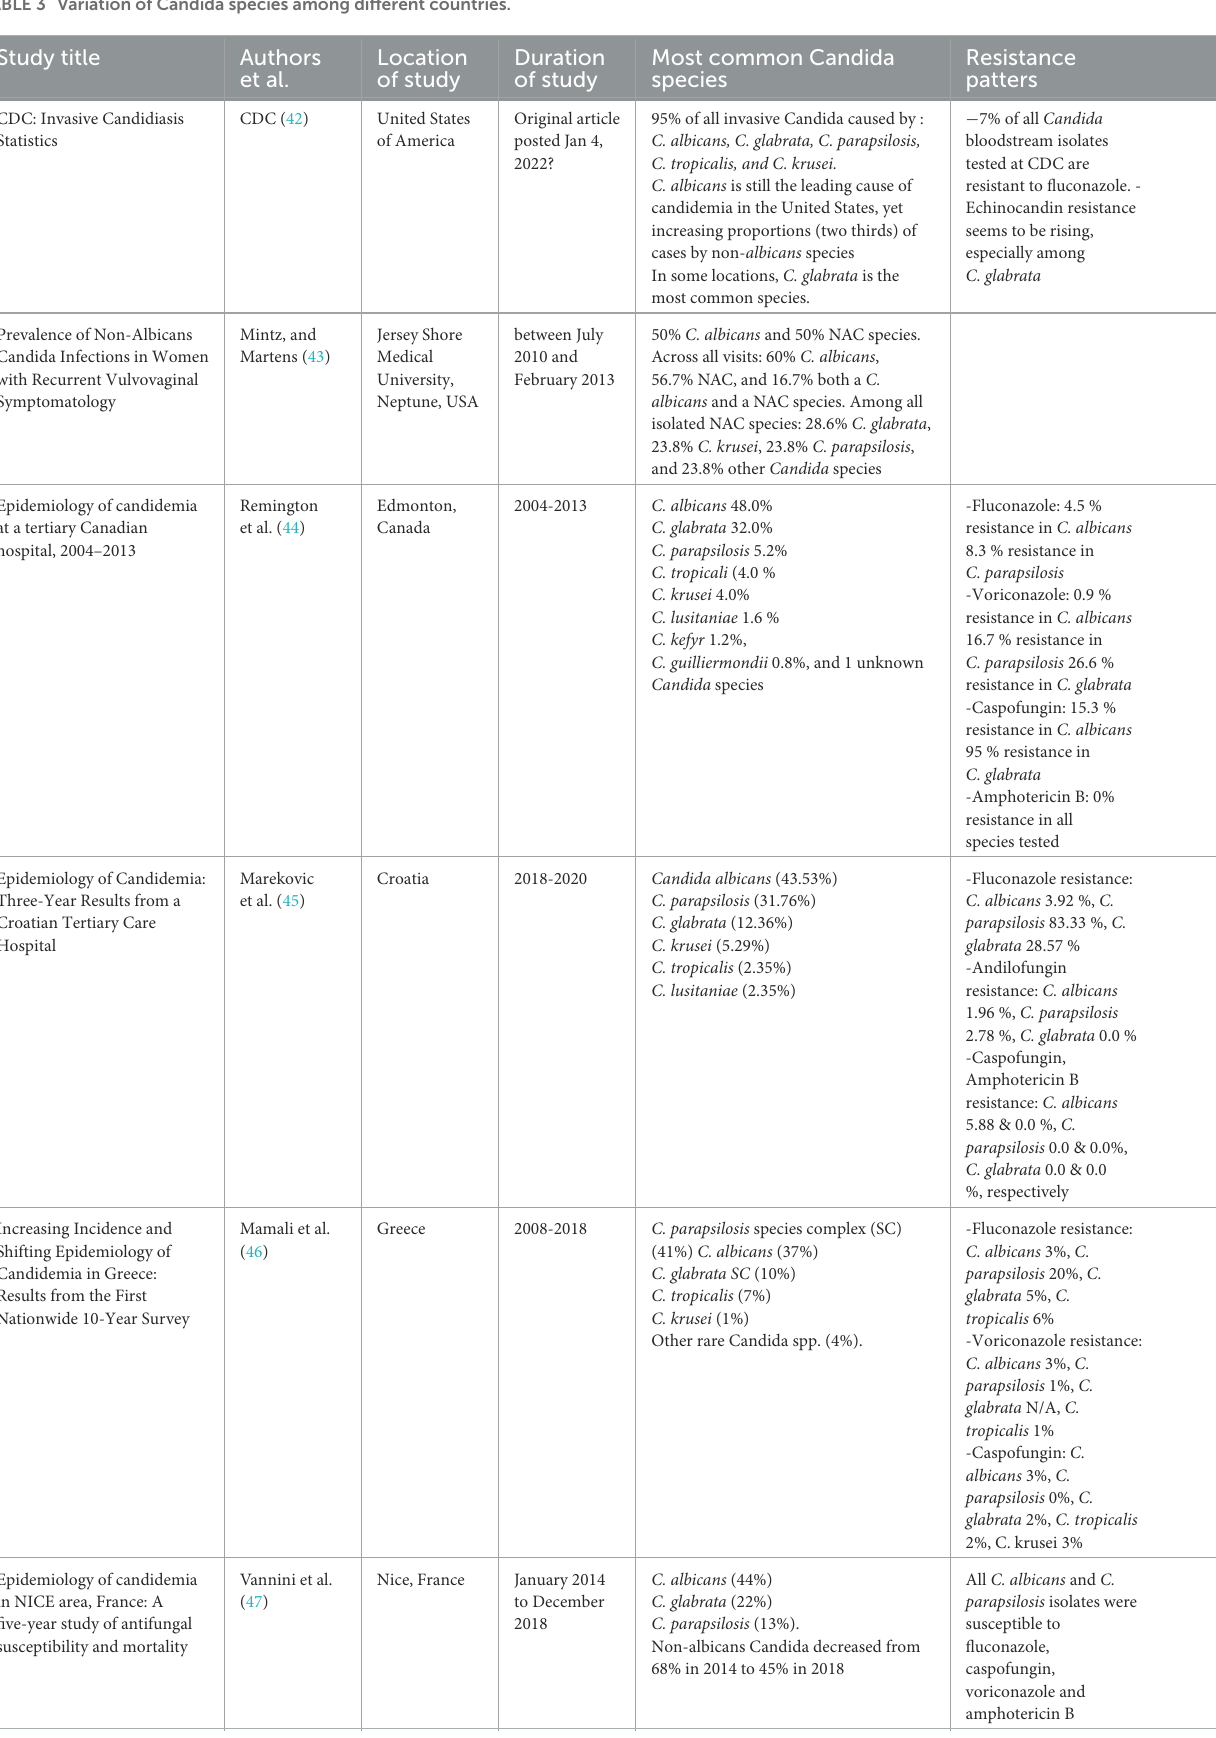
TABLE 3 Variation of Candida species among different